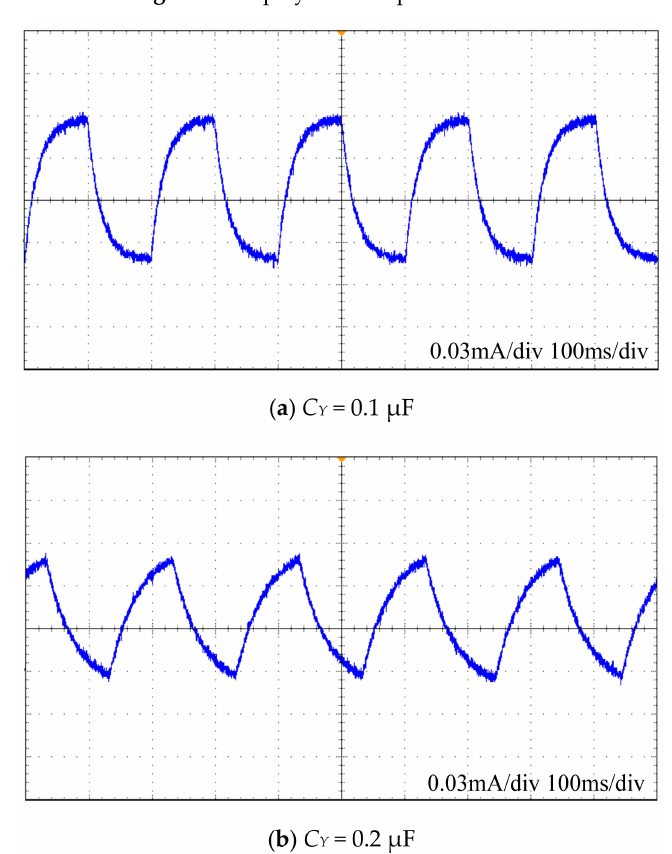
Figure 9. Display of the experiment table.